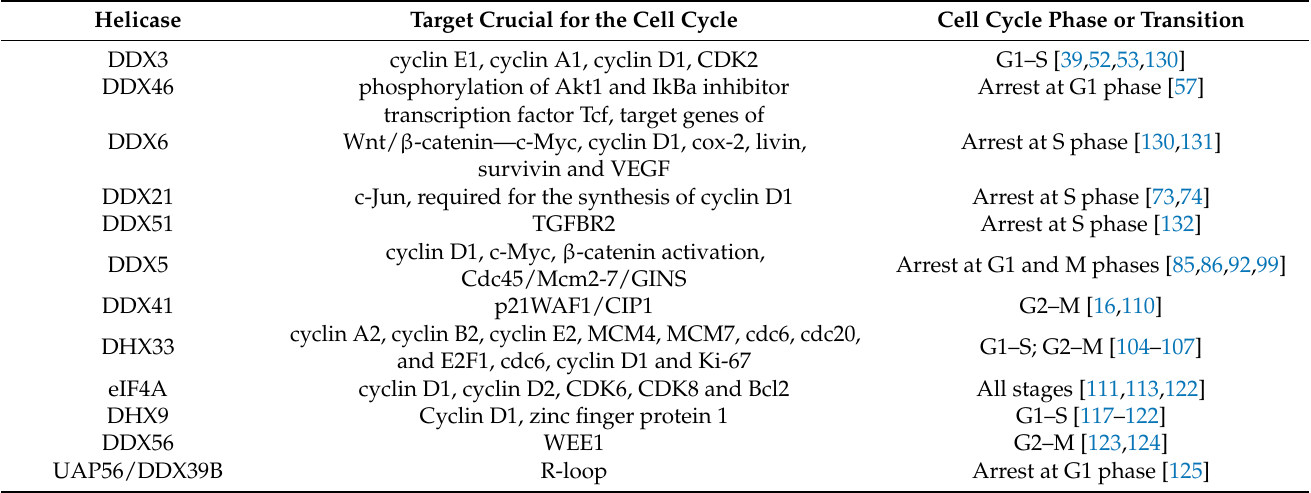
Table 1. Summary of the RNA helicases involvement in the cell cycle